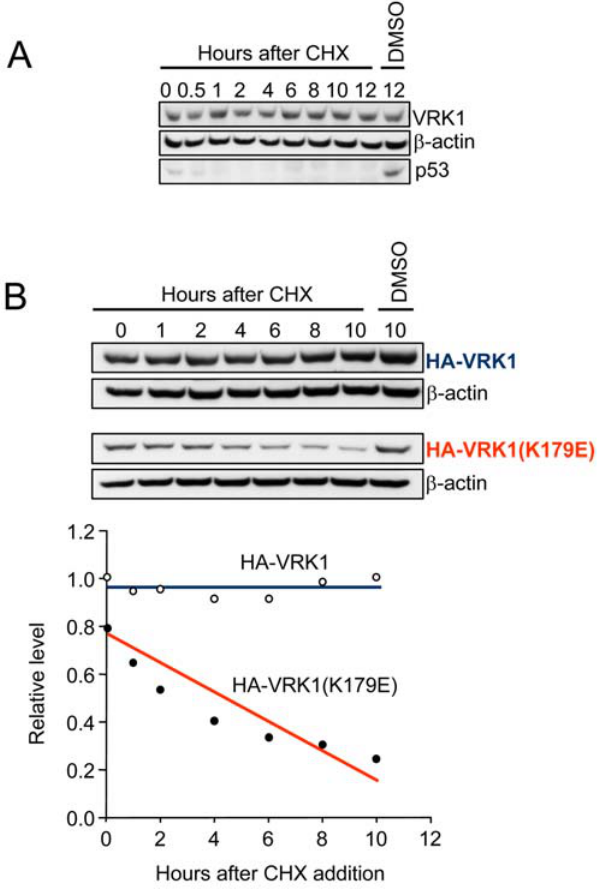
Figure 5. Stability of endogenous or transfected VRK1 protein. ( A ) The variation in levels of endogenous VRK1 and p53 proteins in HeLa cells was followed at different time points after addition of cycloheximide. The p53 protein drops in less than 30 minutes as expected, but there is no detectable change in VRK1 protein even after twelve hours suggesting it has a very high stability. ( B ). HEK293T cells were transfected with plasmids expressing wild-type human VRK1 or its kinase-dead K179E mutant. The stability of both proteins was followed at different time points after cycloheximide addition. Cells were transfected with plasmids pCEFL-HA-VRK1 or pCEFL-HA-VRK1(K179E) as previously described (Vega et al., 2004). These experiments were independently performed three